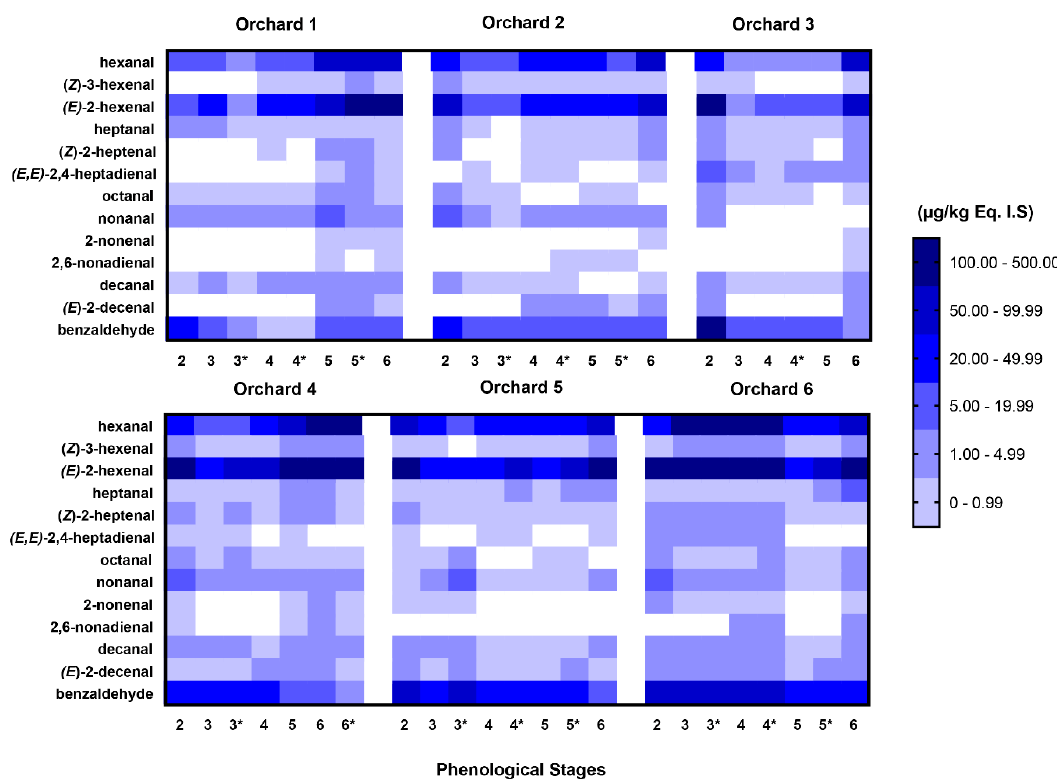
Figure 3. Volatile aldehydes concentration in pulped Regina sweet cherries during development in orchards 1 to 6. 3*, 4*, 5* and 6* indicate samples with the herbaceous flavor. White cells mean absent or not detected.